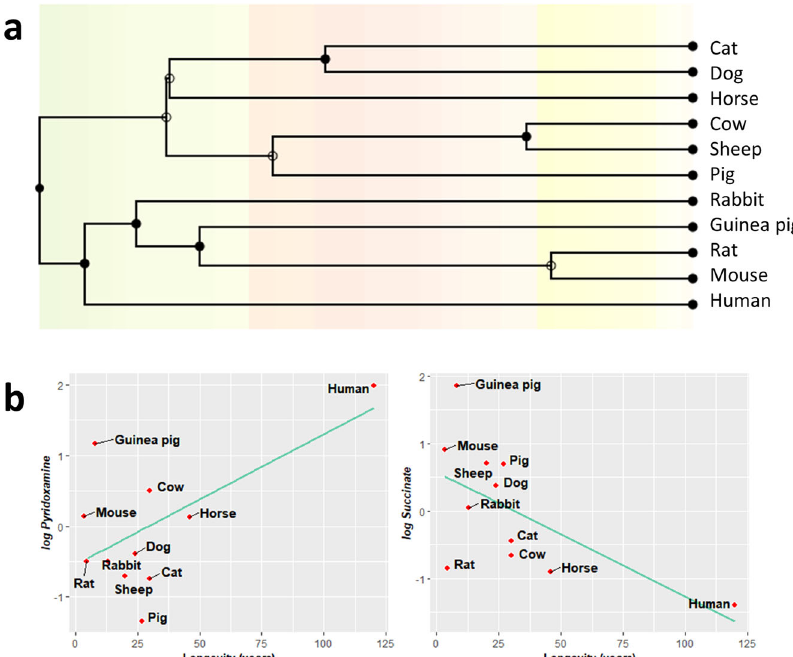
Fig. 7 Plasma metabolites changes across mammalian longevity after correcting for phylogenetic relationships. a Phylogenetic tree with a timescale of million years ago. b Phylogenetic generalized least squares (PGLS) regression between longevity and plasma content of pyridoxamine and succinate. Minimum signi fi cation level was set at p < 0.05. All metabolites were log-transformed in order to accomplish the assumptions of normality. Data values are obtained from four (mice and cows), fi ve (rats, rabbits, guinea pigs, sheep, dogs, pigs, cats and horses) or six (humans)